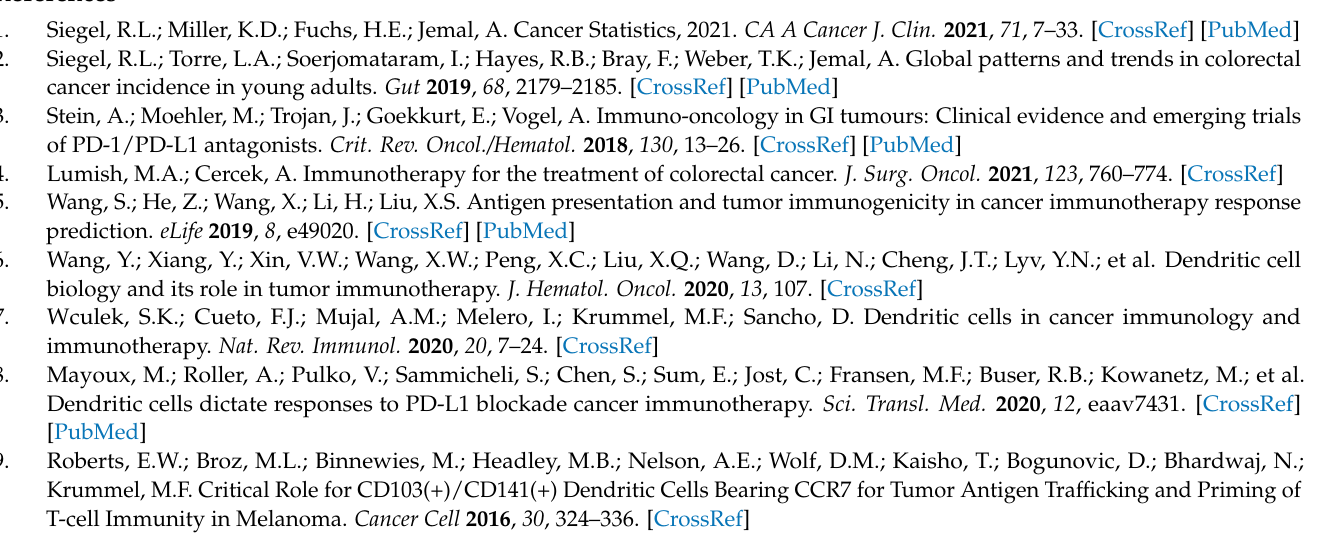
CRC dataset, Figure S2: ACKR4 expression and tumor immune infiltration, Figure S3: Full Western blot images for Figure 1E, Figure S4: Full Western blot images for Figure 2A, Figure S5: Full Western blot images for Figure 2C, Table S1: Key